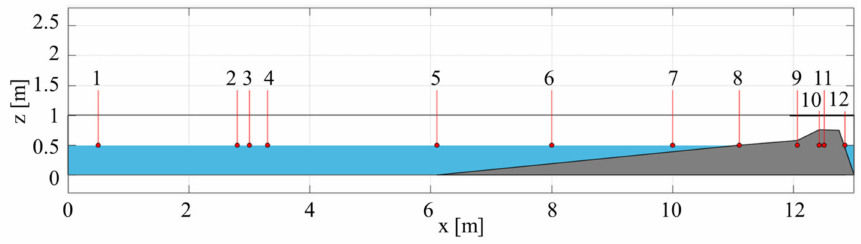
Figure 4. Numerical beach profile configuration (reduced scale) used in the IH2VOF model in case I.NO. Location of the 12